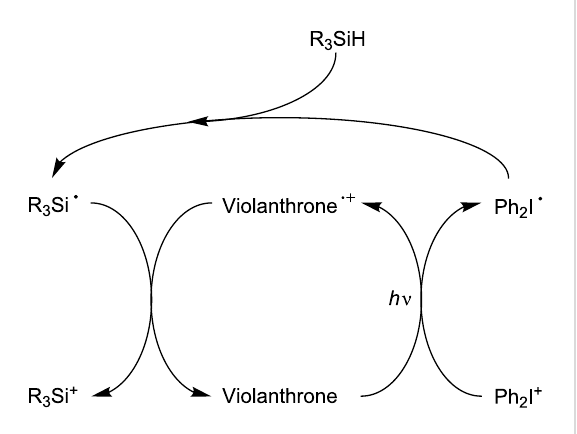
Scheme 9: Reaction mechanisms for the violanthrone/Ph 2 I + /TTMSS (R 3 SiH) system upon red lights.